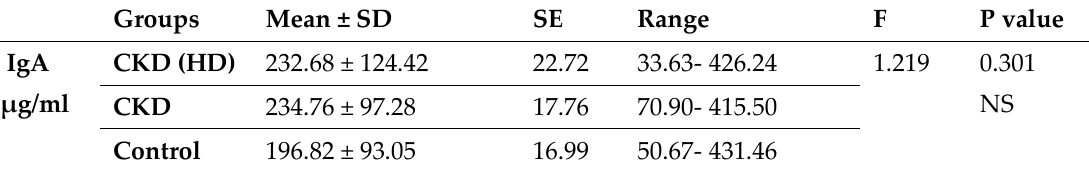
Table 4: Mean salivary IgA level in studied groups with ANOVA